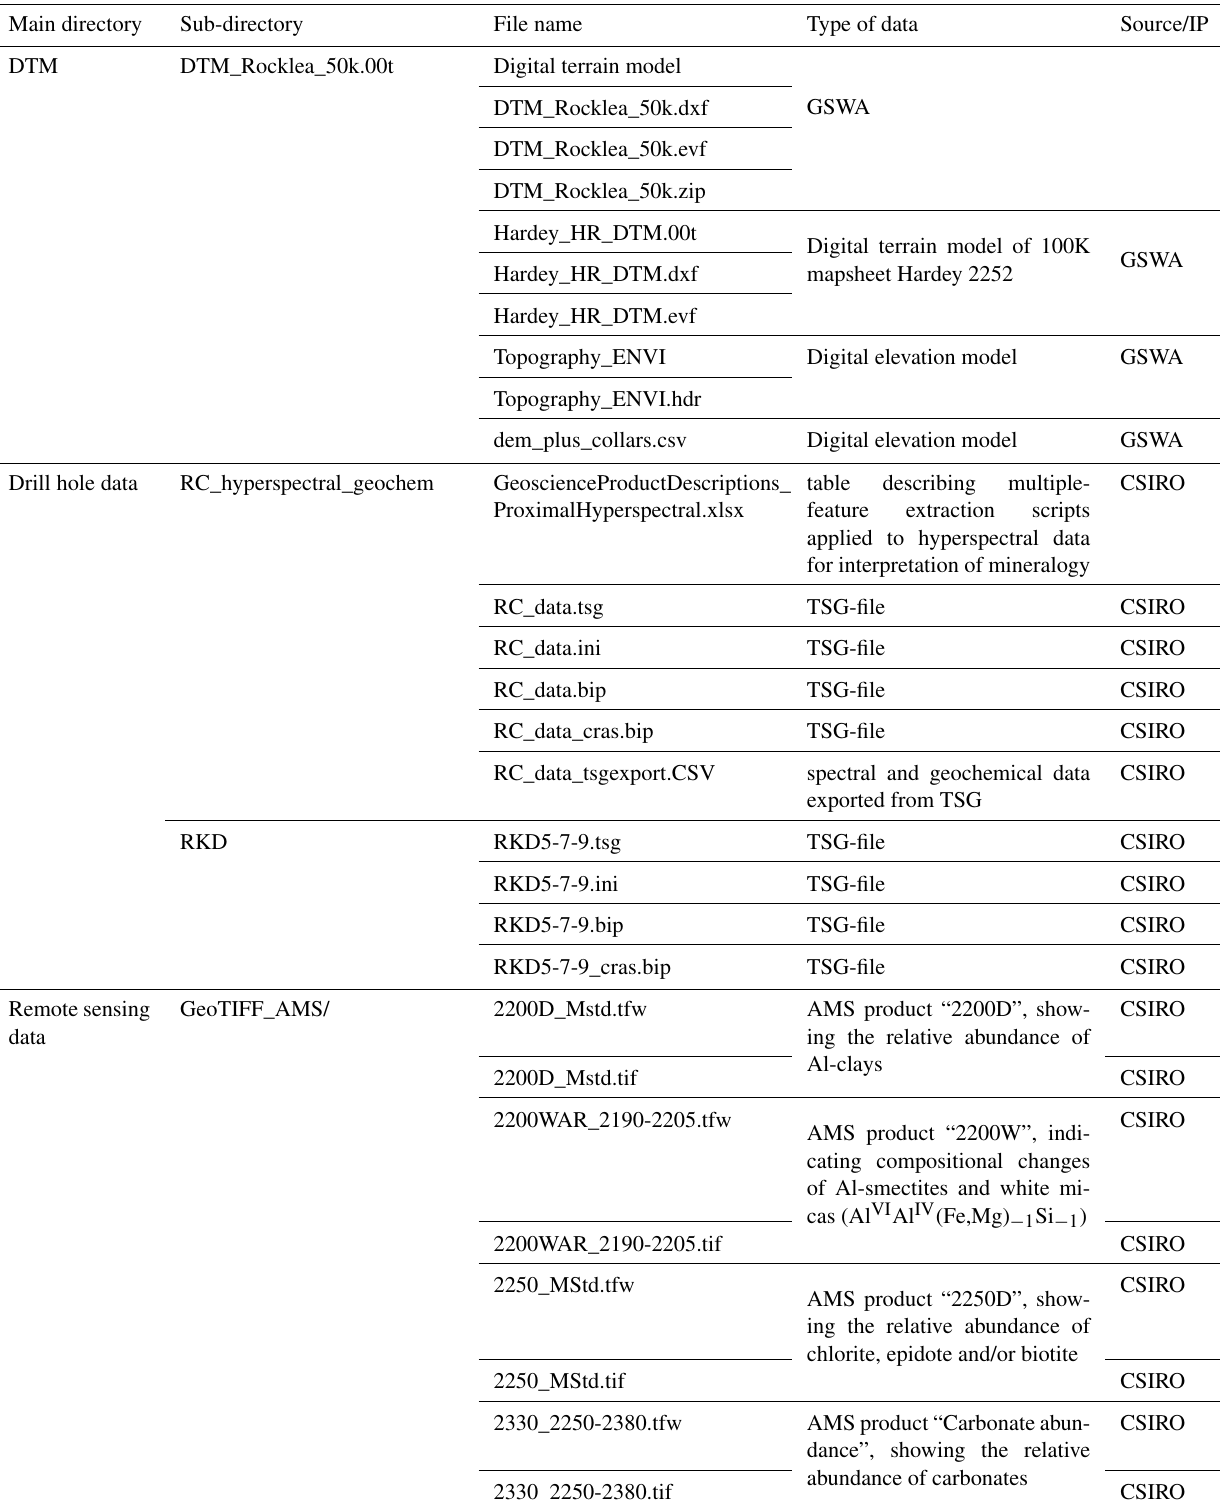
Table 2. Publicly accessible data of the Rocklea Dome 3D Mineral Mapping project (https://data.csiro.au/collections/#collection/CIcsiro: 44783, last access: 15 March 2021; https://doi.org/10.25919/5ed83bf55be6a, Laukamp,